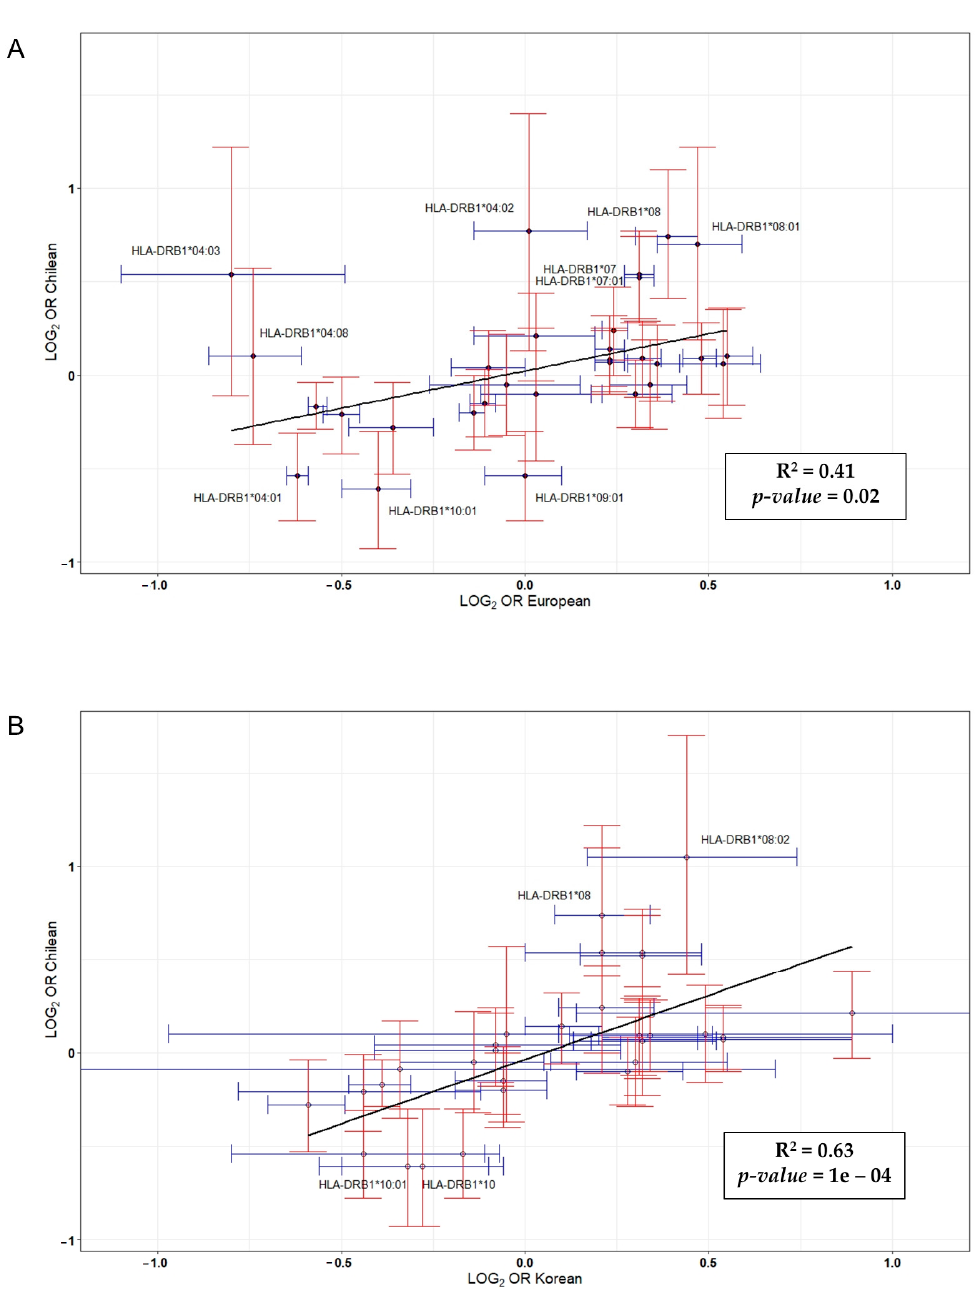
Figure 2. Correlation between log(odds ratio) from data published in a genome-wide association (GWA) study carried out in Caucasian ( A ) and Korean ( B ) populations versus log(odds ratio) reported in this study